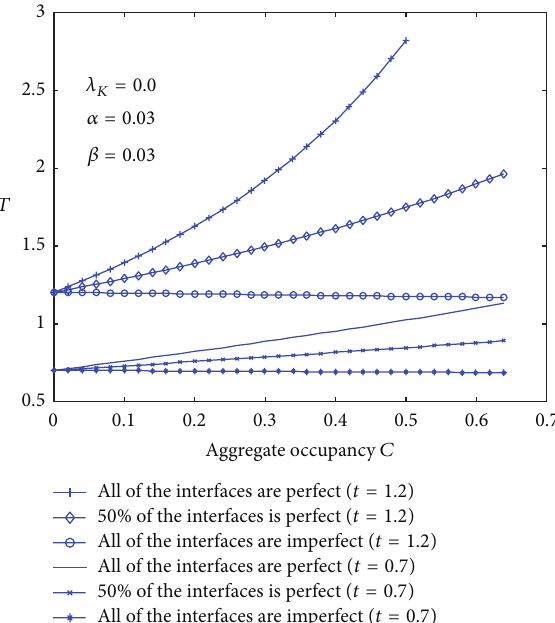
Figure 3: The change curve of the macroscopic inner friction coefficient with aggregate occupancy for different matrix inner friction coefficient ( 𝜆 𝐾 = 0.0 ).